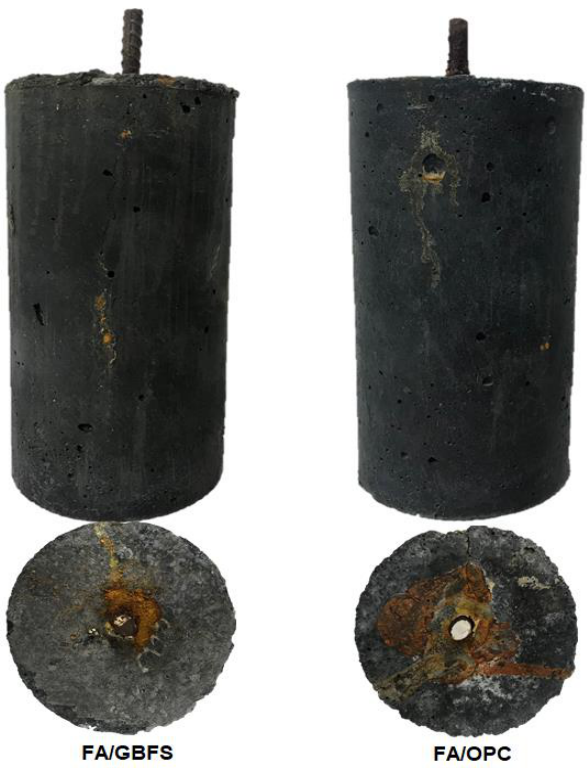
Figure 7. Photographs of the concretes after the impressed voltage test.